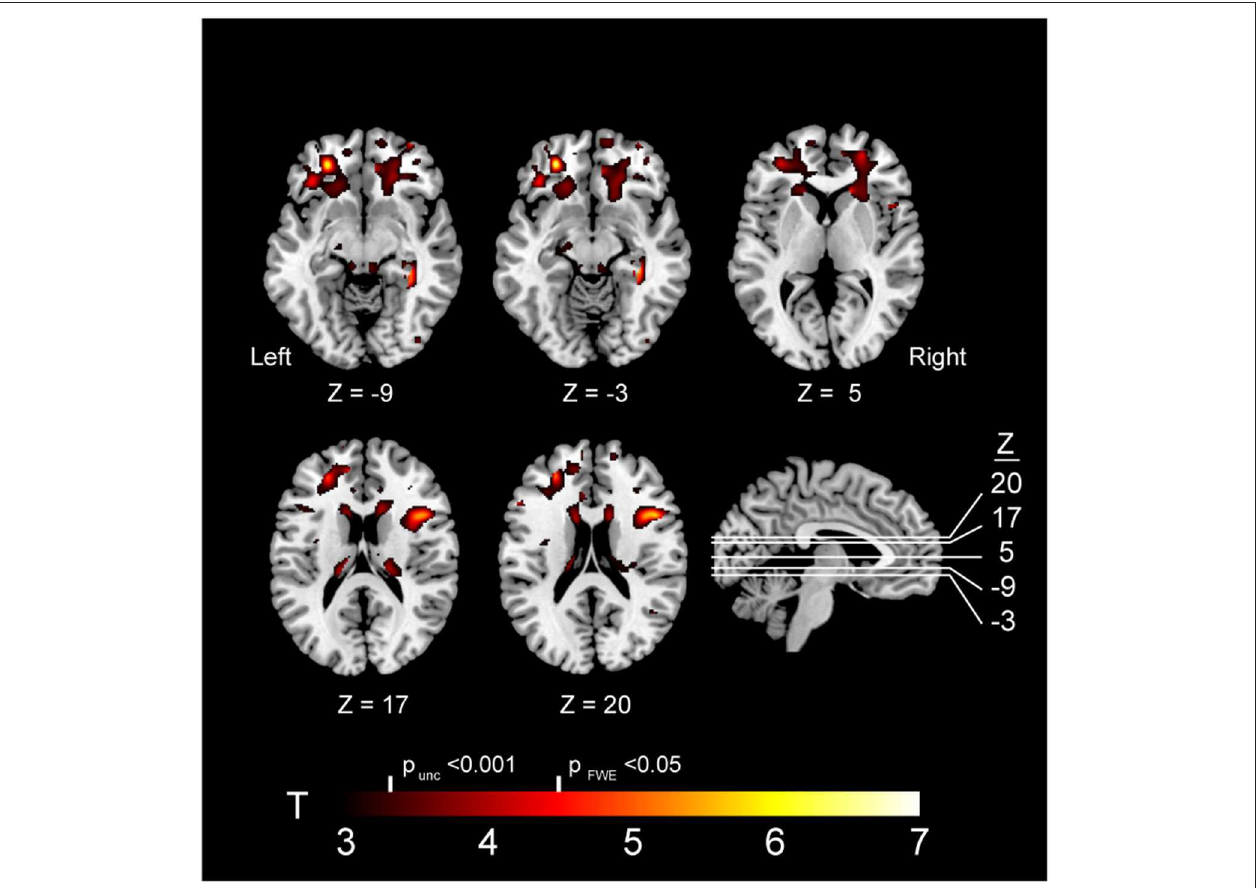
FIGURE 4 | Brain atrophy associated with elevated plasma LBP in GRN carriers. Abbreviations: FWE, familywise error; LBP, lipopolysaccharide; unc, uncorrected. Note: The depicted clusters were obtained via voxel-based morphometry (VBM) analysis modeling an interaction between GRN mutation carriers status and plasma LBP in determining atrophy in our study cohort (including controls and mutation